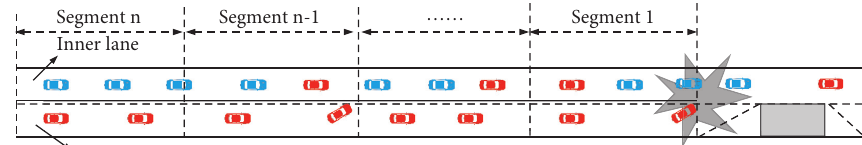
Figure 5: Vehicle driving status near a freeway work